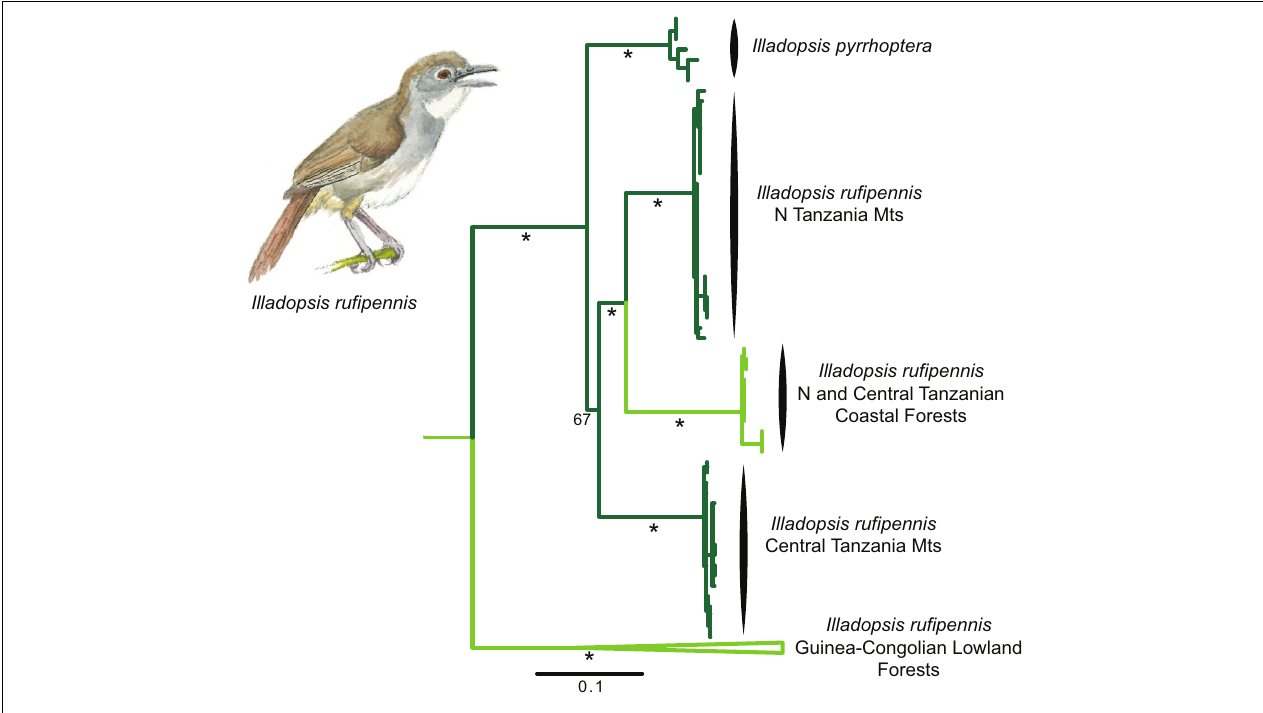
FIGURE 5 | Mitochondrial DNA (ATP6, ND2) phylogeny of Illadopsis species of east Africa derived from a partitioned maximum likelihood analysis. Note that I. pyrrhoptera renders I. rufipennis polyphyletic. Dark green branches are indicative of lineages that occupy montane forest, intermediate green is indicative of lineages that occupy a broad range of elevations and light green lineage occupies lowland forest. * > 75% bootstrap support.